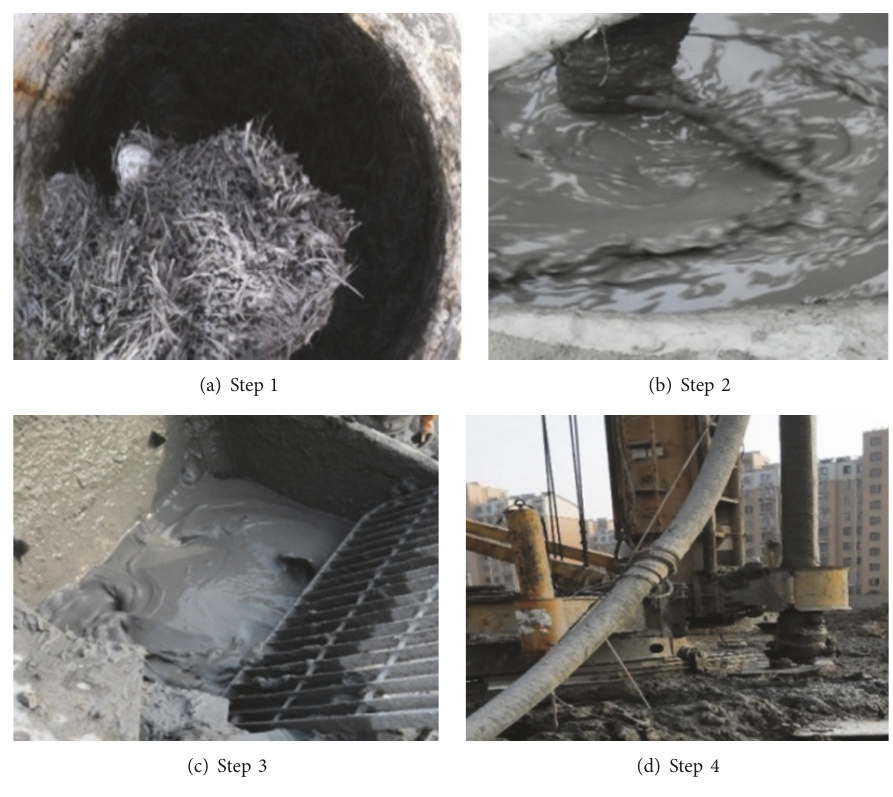
Figure 14: Site construction of cement-soil pile with basalt fibre.